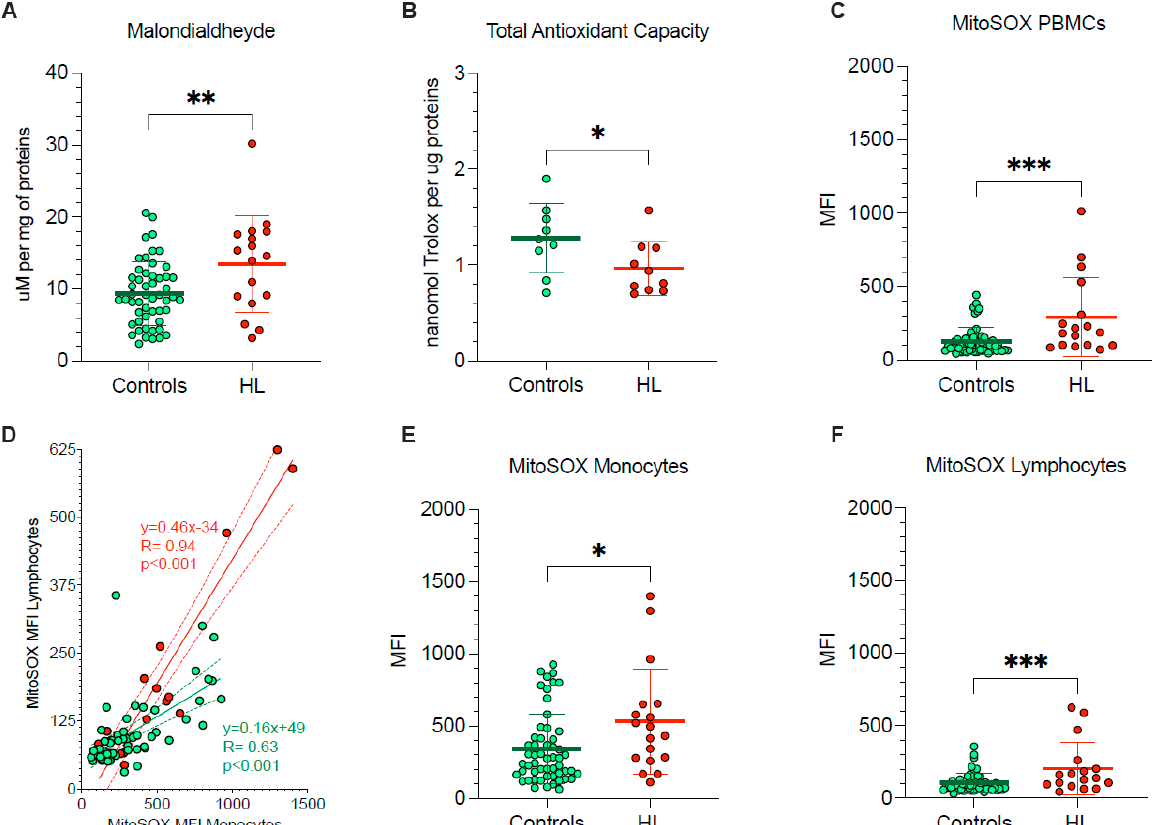
Figure 2. PBMCs oxidative stress and antioxidant response. ( A ) Malondialdehyde content and ( B ) total antioxidant capacity evaluated in lysed PBMCs. ( C ) Mean fluorescence intensity (MFI) of MitoSOX evaluated in all PBMCs of controls (green) and HL patients (red). ( D ) Correlation between MitoSOX MFI in monocytes (x-axis) and lymphocytes (y-axis) of controls (green) and HL patients (red). Simple linear regression (continuous line) and 95% confidence bands of the best-fit line (dashed line) of controls (green) and HL patients (red). MitoSOX signal measured as mean fluorescence intensity (MFI) in lymphocytes ( E ) and in monocytes ( F ) of controls (green) and HL patients (red). Graphs display individual data and mean ± SD. * = p < 0.05, ** = p < 0.01, *** = p < 0.009.